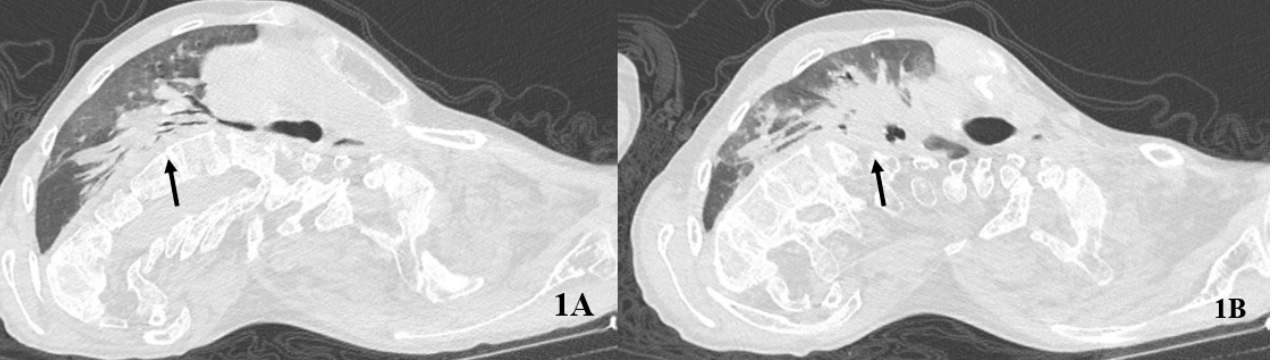
Figure 1. Baseline computed tomography of the chest. The arrows indicate an extensive consolidation from the right hilum ( A ) to the right lower lobe ( B ).